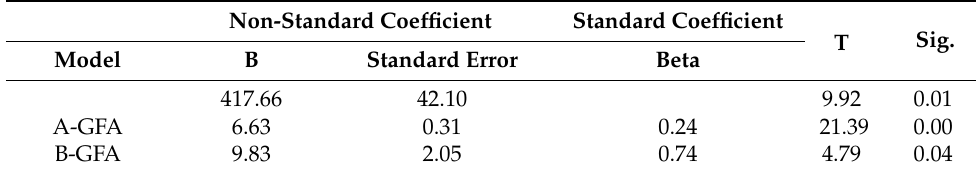
Table 14. Corresponding